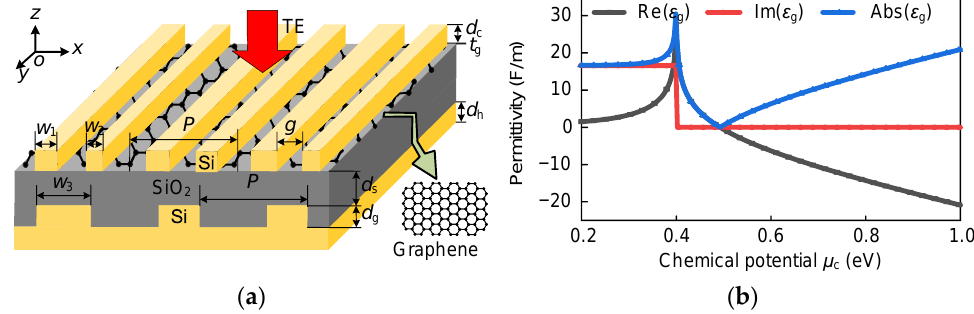
Figure 1. ( a ) Schematic of the near-perfect proposed graphene absorber. ( b ) Relationship between permittivity and chemical potential of graphene at 1550 nm.